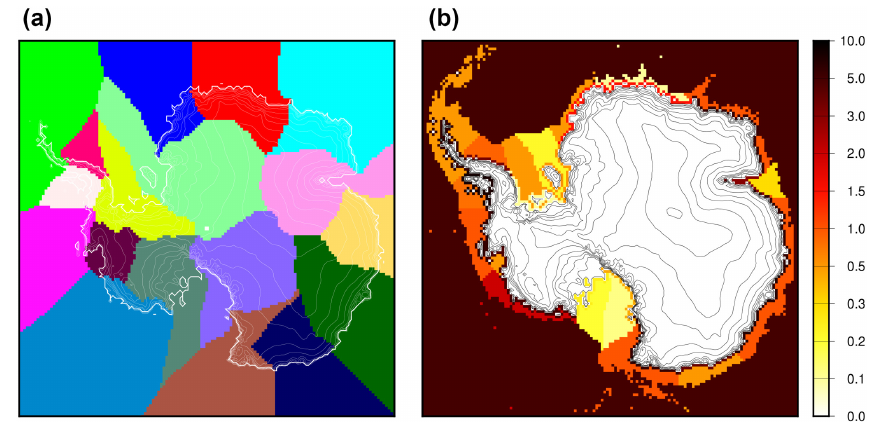
Figure 3. Antarctic ice shelf sectors (a) and associated prescribed present-day sub-shelf basal melting rates in myr − 1 (b) . The melting rates are different for the shelf and the associated grounding line to mimic the higher values observed close to the grounding line (Rignot et al., 2013). Sub-shelf melting rates for the deep ocean (depth greater than 2500m) are assigned a value of 5myr − 1 .